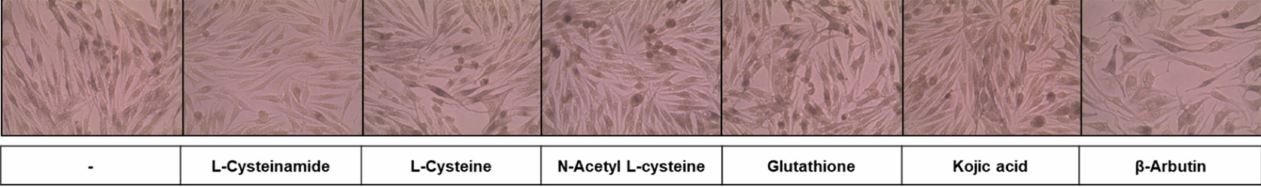
Figure 3. Effects of L-cysteinamide, L-cysteine, N-acetyl L-cysteine, glutathione, kojic acid, and β -arbutin on the mor- phology and pigmentation of MNT-1 cells. Cells were treated with each substance at 1.0 mM for 72 h and subjected to Fontana-Masson